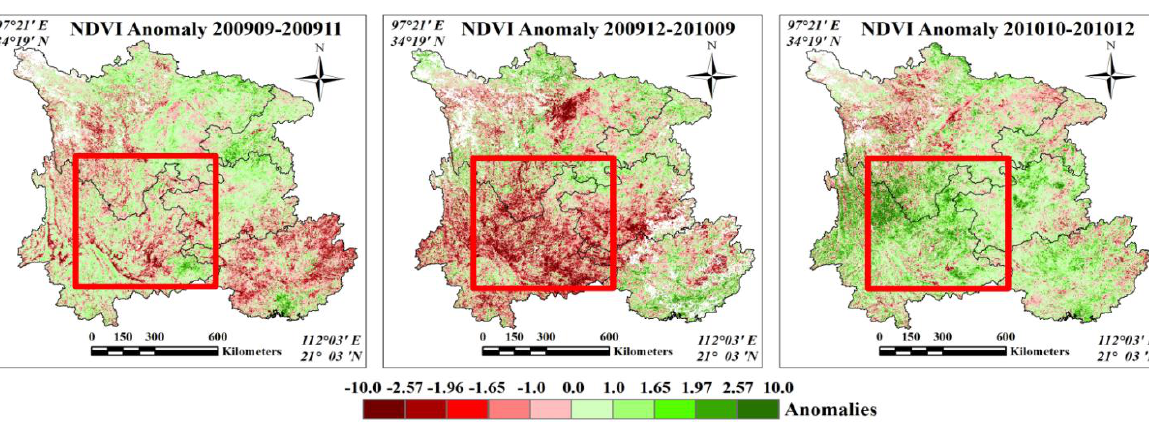
Figure 3. PDSI distribution frequency ( up ) and spatial distribution ( down ) in the three time periods: initial stage ( left ), middle stage ( middle ), and final recovery stage (right) . The red square area is our study area, and experienced serious drought during 2009 to 2010.